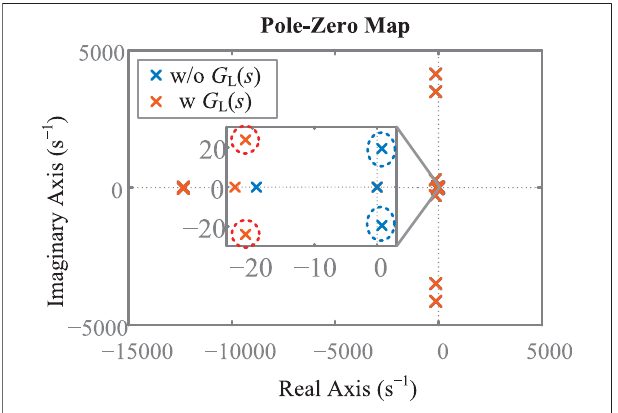
FIGURE 7 | Eigenvalues of A with and without the designed lead